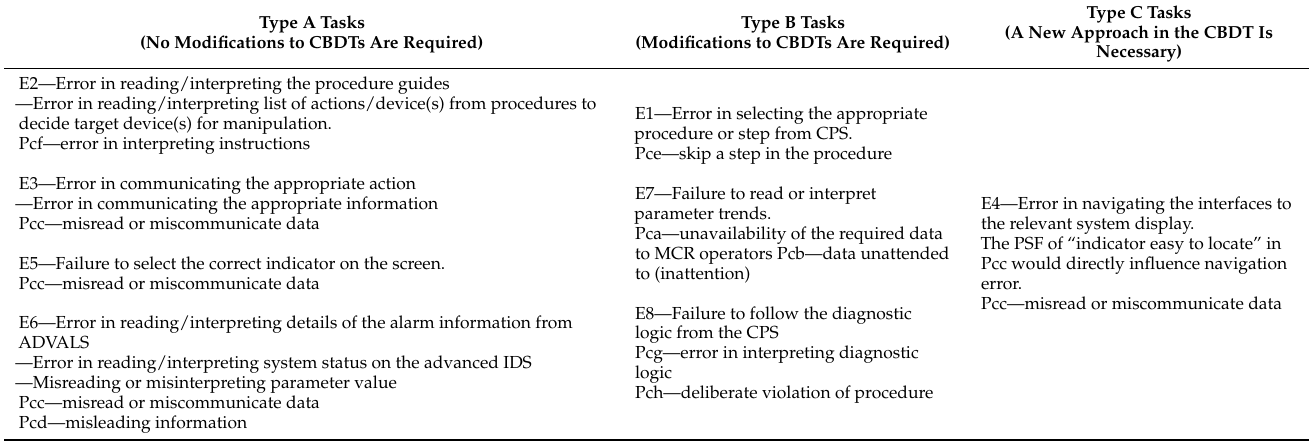
Table 2. Task types with applicable